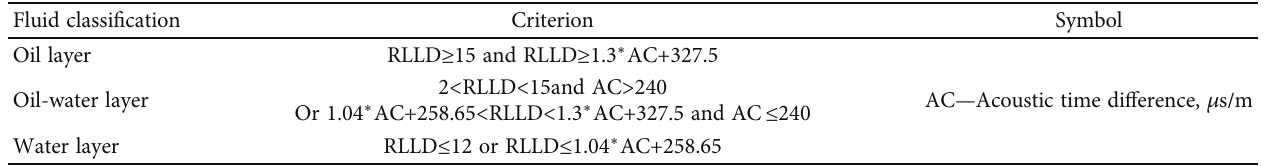
Table 9: Discrimination standard table.